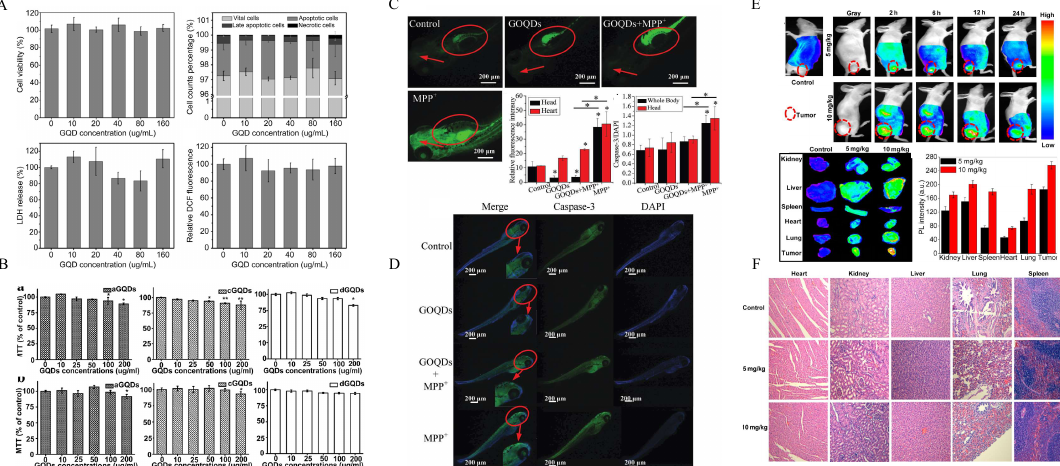
Figure 3. Toxicity of GQDs. ( A ) Cell viability tests and reactive oxygen species (ROS) production on HeLa cells. Reprinted from [64]. Copyright 2014, permission from Elsevier; ( B ) Cell viability on A549 (top) and C6 (bottom) after the treatment with aminated GQDs (aGQDs), carboxylated GQDs (cGQDs) and DMF GQDs (dGQDs). Reproduced with permission [38]; ( C ) Oxidative stress on zebrafish after the treatment with MMP and GQDs with relative fluorescence intensity on head and heart. Reprinted from [65]; ( D ) Fluorescence intensity of caspase-3 after the treatment with GQDs and MMP [65]; ( E ) In vivo and ex vivo imaging of mouse after injection with carboxylated GQDs [67]; ( F ) Accumulation of different concentrations of carboxylated GQDs in mouse organs, 160× magnification. E and F were reprinted with permission [67]. Copyright 2013, American Chemical Society.